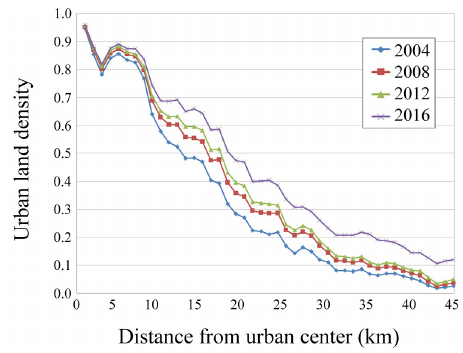
Figure 4. Urban land density of Bangkok versus distance from the city center, for the years 2004, 2008, 2012, and 2016. LULC Landsat maps were used to select the “urban” category